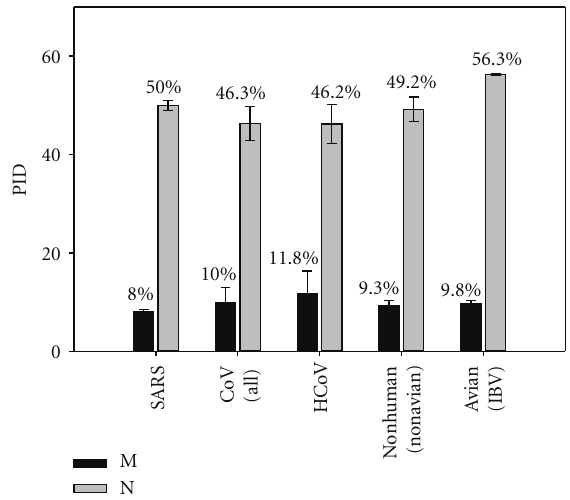
Figure 2: Comparison of the mean PID of membrane (matrix glycoprotein, M) and nucleocapsid (N) proteins of human and nonhuman coronaviruses. Mean PIDs in the N- and M-proteins of avian coronavirus are shown for comparison.